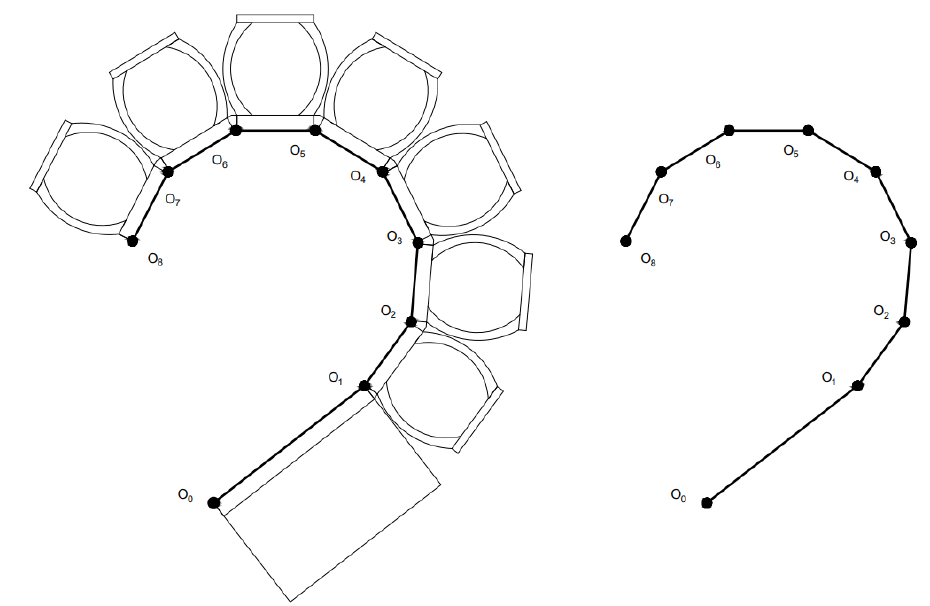
Figure 10. Vectorial representation of a backbone curve for a soft